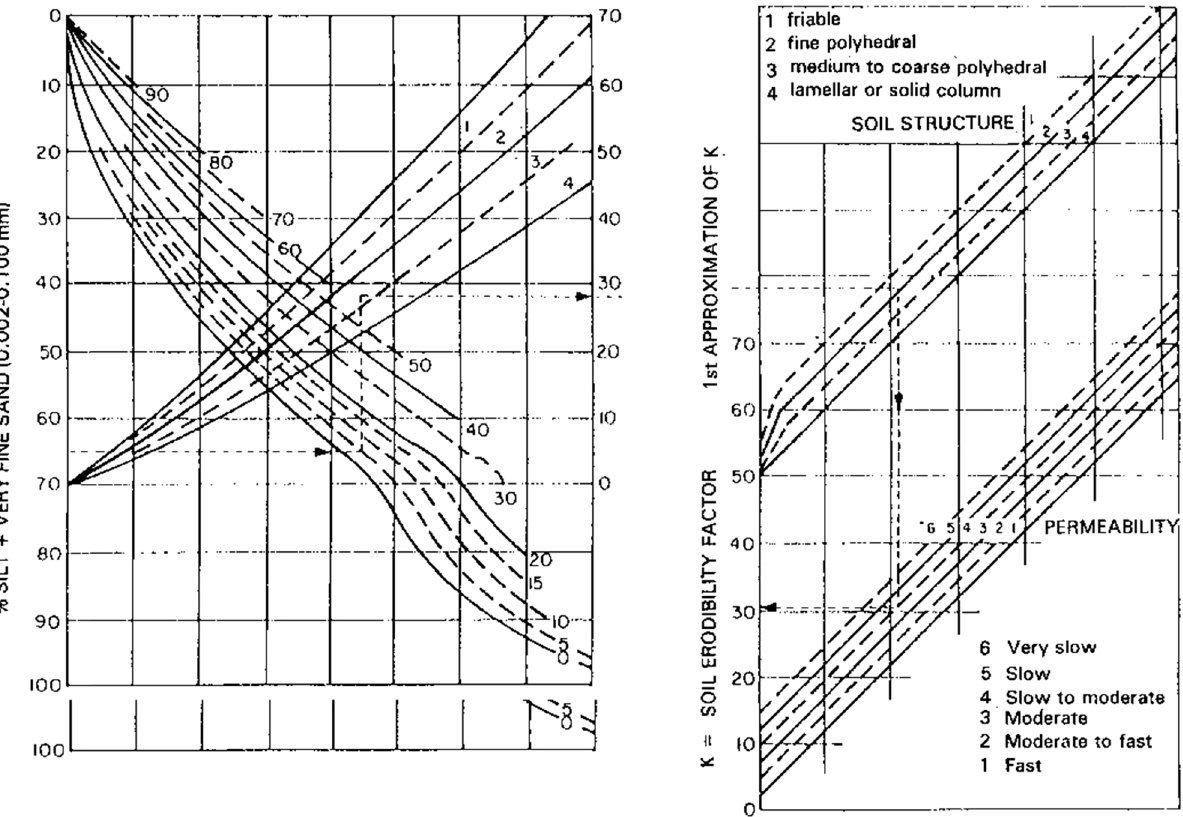
Figure 6: The monograph to extract soil erodibility factor [ 21 ] .